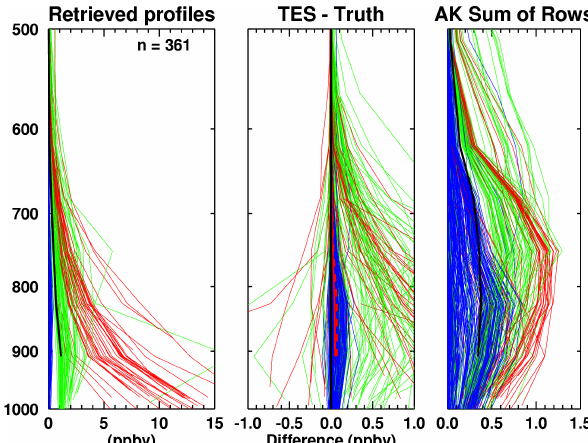
Fig. 9. RVMR values for simulated retrievals: spectra are identical, but a priori selection schemes are different. Red results are from a retrieval in which the a priori could be polluted, moderate or unpol- luted, while blue results are from a retrieval in which the polluted a priori was changed to moderate, and the moderate was changed to unpolluted (top). Difference in RVMR as a function of DOF (bot- tom).